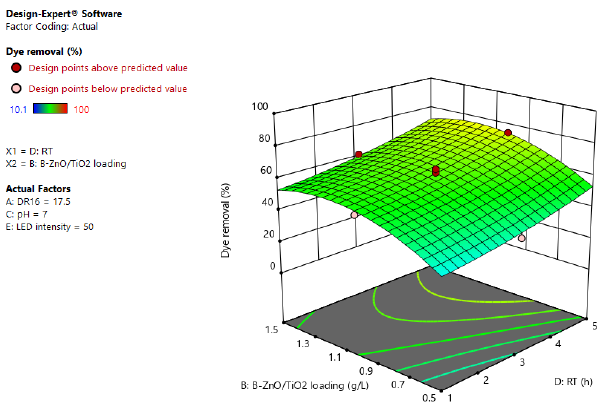
Figure 8. Three-dimensional surface plots of dye removal efficiency as a function of reaction time and B-ZnO/TiO 2 loading at [DR16] = 17.5 mg/L, pH = 7, and LED intensity =